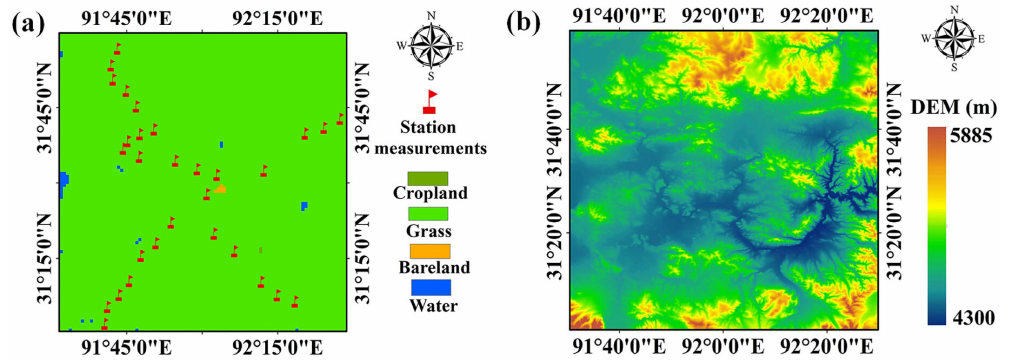
Figure 1. Overview of the study area: ( a ) land-cover map and station locations; ( b ) DEM.